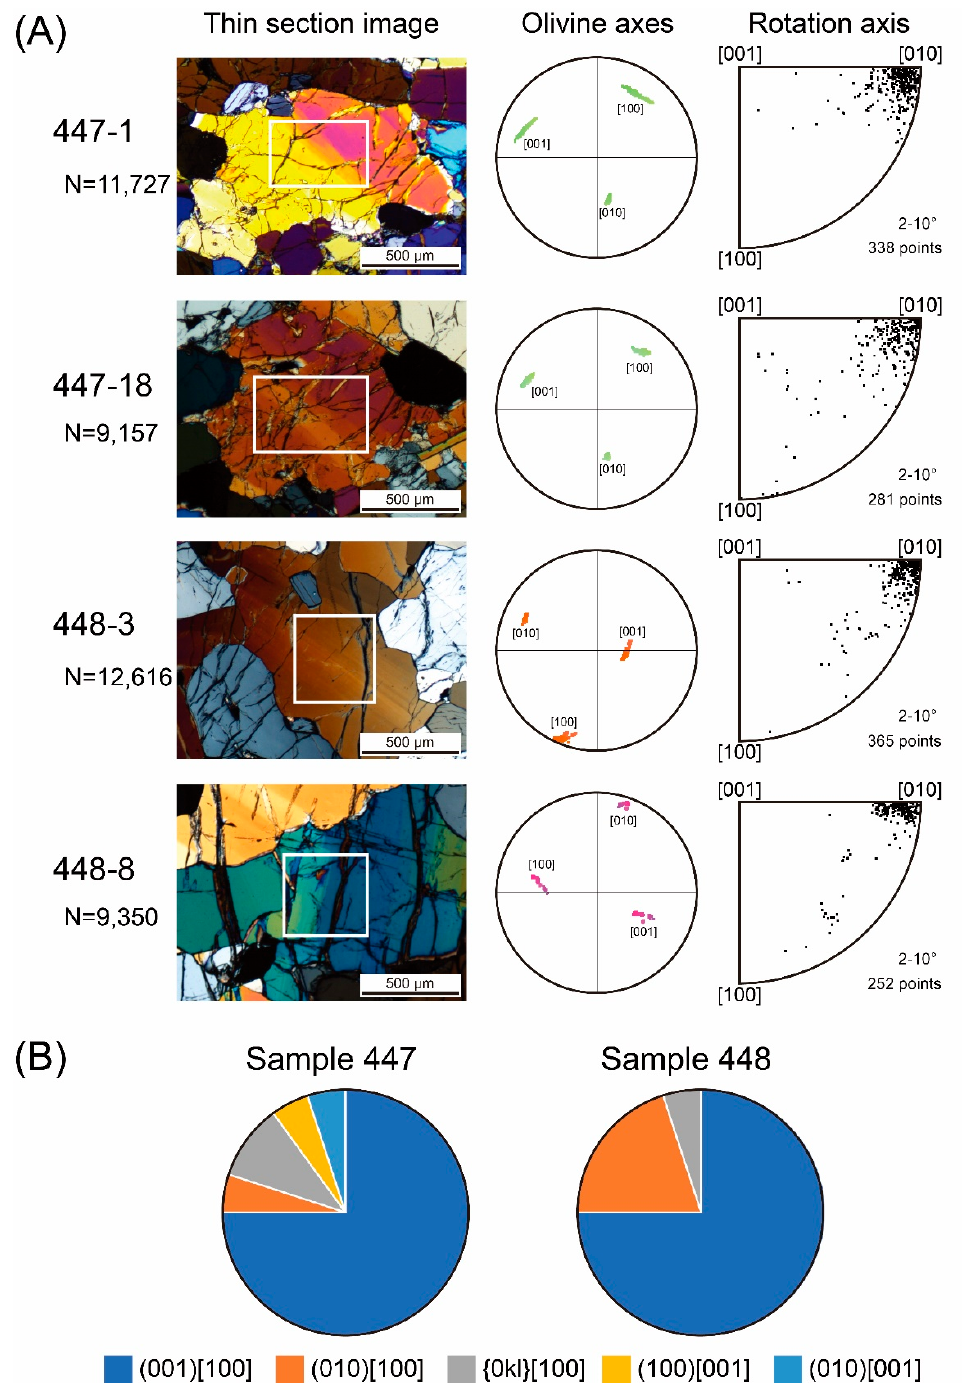
Figure 3. Identification of olivine slip system from olivine subgrain boundaries. ( A ) Microphotographs of samples 447 and 448 and the associated EBSD mapping across olivine subgrain boundaries. The (001)[100] slip system was identified from all four olivine subgrain boundaries. White rectangles in the microphotographs constitute the actual EBSD Mapping area. The [100], [010], and [001] olivine crystallographic axes are plotted in the lower hemisphere of the stereonet. The rotational axis distribution with misorientation angles of 2–10 ◦ is plotted in the inverse pole Figure. N is the number of data points for each EBSD Mapping. ( B ) Pie chart illustrating the different slip systems determined by EBSD Mapping along olivine subgrain boundaries (See Supplementary Figure S1).